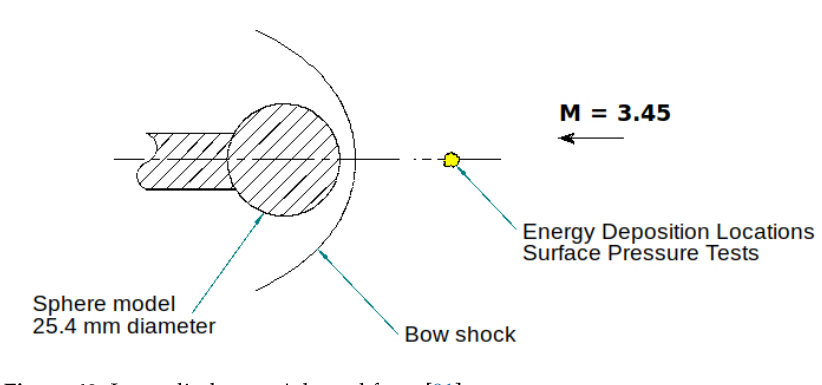
Figure 42. Laser discharge. Adapted from [91]. Figure 43 compares the computed and experimental centerline pressure on the sphere. Also shown are the simulations by Kandala and Candler [92] and Zheltovodov et al. [93]. All simulations show differences compared to the